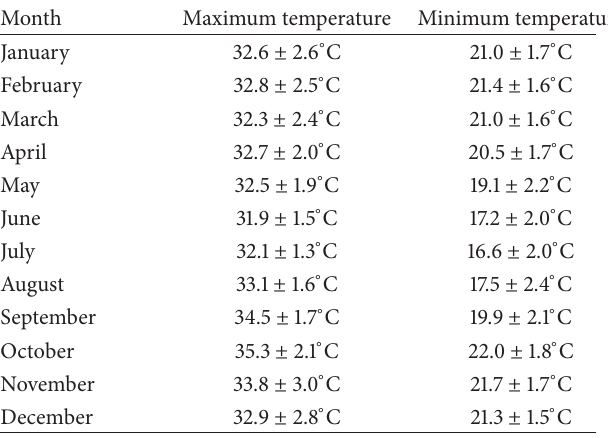
Table 1: Monthly mean temperatures measured in a meteorological station at Barra, Bahia, from 1978 to 2008. Data obtained from INMET (http://www.inmet.gov.br/).